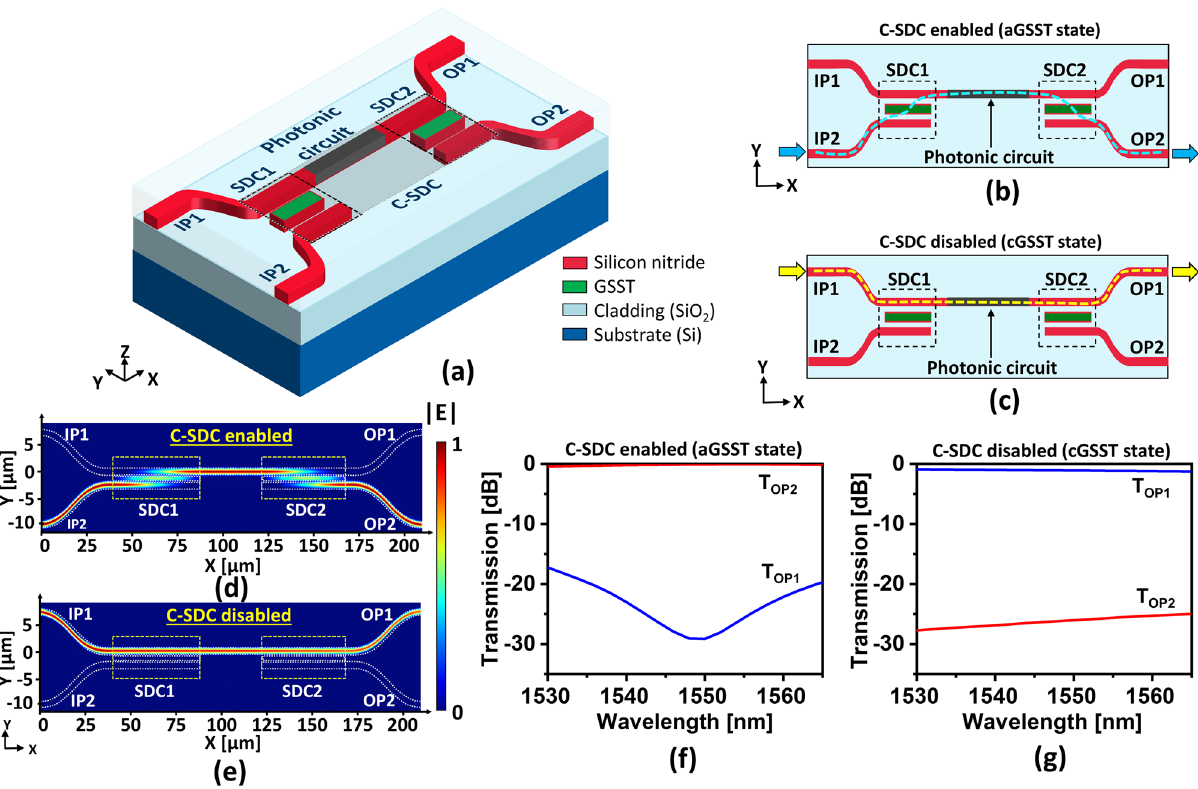
Figure 7. ( a ) Schematic of the proposed C-SDC where both SDC1 and SDC2 are linked to each other via a photonic circuit. The operation of the C-SDC ( b ) under aGSST state where input light from IP2 couples to the photonic circuit through SDC1 and couples back to OP2 through SDC2 and ( c ) under cGSST state where light from IP1 undergoes no cross coupling induced by SDC1 and SDC2, eventually exiting OP1. Optical coupling characteristics under ( d ) aGSST and ( e ) cGSST states. The transmission spectra of T OP1 and T OP2 as observed at the OP1 and OP2 ports for the cases of C-SDC overlaid with ( f ) aGSST and ( g ) cGSST, respectively.